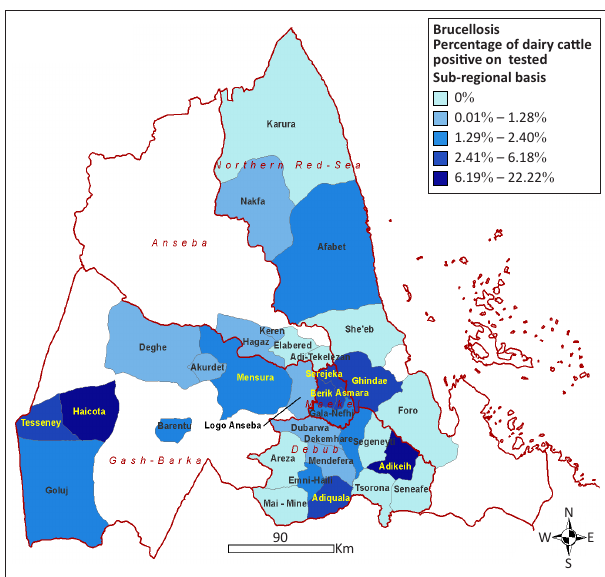
Brucellosis Percentage of dairy cattle positive on tested Regional basis No surveillance